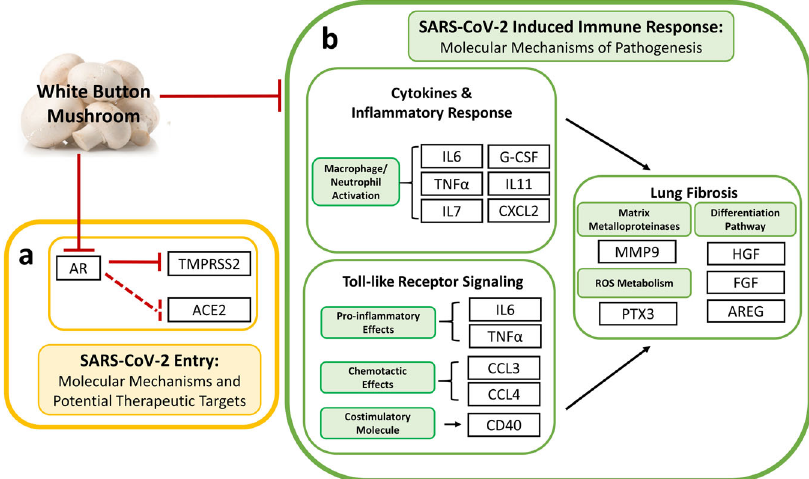
Fig. 6 Hypothetical mechanisms of WBM as a dietary intervention for COVID-19. a WBM interrupts AR-mediated TMPRSS2 expression that is involved in viral entry, through its AR antagonistic activity, and b WBM attenuates serum pro-in fl ammatory cytokines and reduces MDSC counts that are involved in the host response to viral infection, through its immunoregulatory